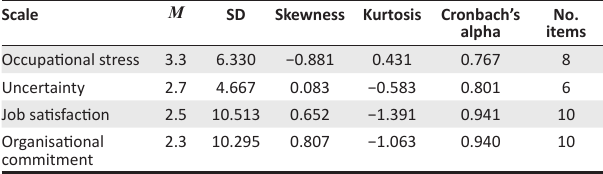
TABLE 2: Descriptive statistics and reliability